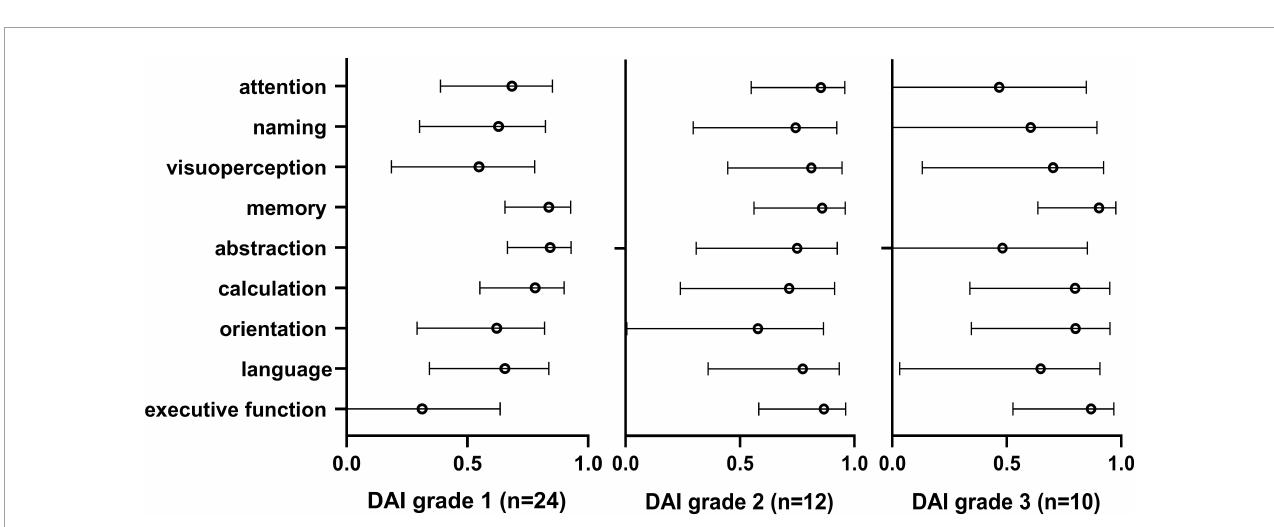
FIGURE3 Pearson correlation analysis was performed between the Ads of nine cognitive domains and MoCA-BC after data conversion in different grades of DAI patients. MoCA-BC, the Chinese version of the Montreal Cognitive Assessment Basic; DAI, Diffuse axonal injury.